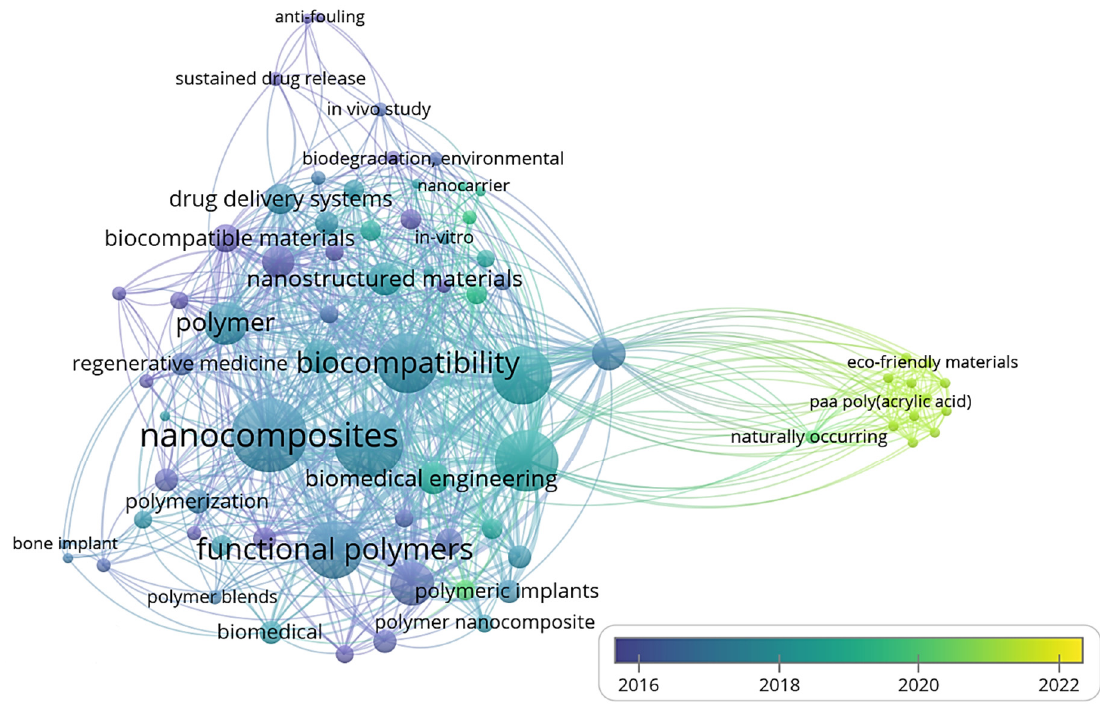
Figure 33. Bibliometric analysis of the utilization of natural polymeric biomaterials and nanopolymers in drug carriers and tissue engineering applications.